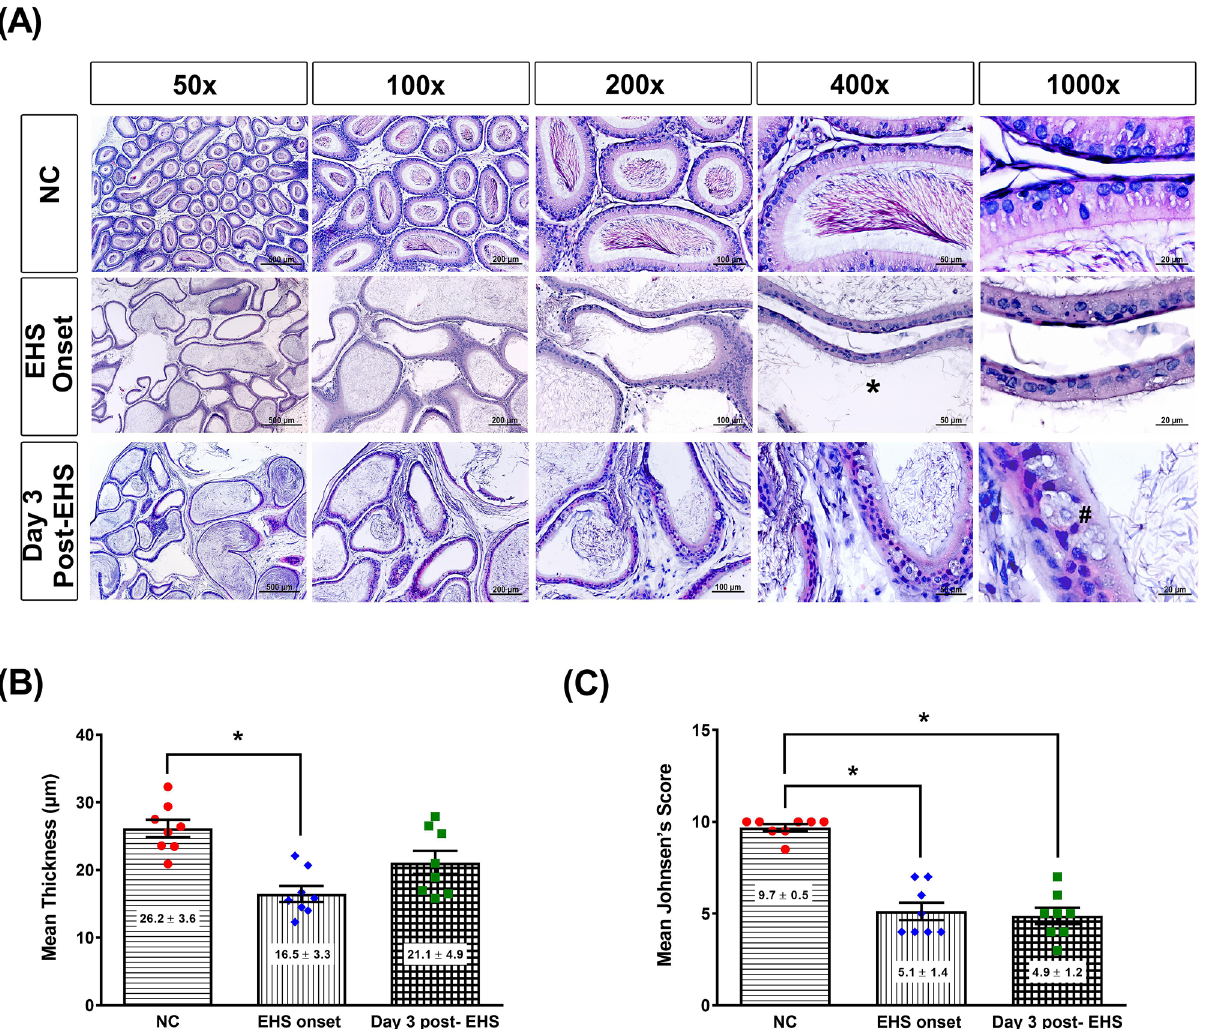
Figure 4. Histological alterations and quantitative analysis of rat epididymis tissues from the three groups. ( A ) Representative histological images are resented, following hematoxylin and eosin staining of the epididymis of rats from the NC, EHS onset, and Day 3 post-EHS. Images of epididymis morphology are shown at ×50, ×100, ×200, ×400 and ×1000 magnification. Scale bars = 500 μm, 200 μm, 100 μm, 50 μm, and 20 μm. ( B ) The mean thickness of the epididymis basement membrane and ( C ) the mean Johnsen’s score were presented as mean ± standard deviation (n = 8 per group). The EHS rats had a reduction of both mean thickness and mean Johnsen’s score of the cytoplasmic membrane, spermatids (#), and cytoplasmic degradation (*). *P < 0.05, EHS onset vs. NC or Day 3 post-EHS vs. hormones, multiple vital organs injury indicators, and disseminated intravascular coagulation (DIC). These EHS reactions lasted at least up to three days post-EHS. All EHS animals that were followed over the 14-day recovery period survived the EHS challenges (data not shown). Heat stress and heat illness arise when ambient tempera- tures are high. They can be triggered by physical exertion even at low-risk temperature 16 . Physical exertion can lead to heat stress and heat illness (due to intense and rapid heat production in the working muscles). Higher environmental temperatures further increase the risk. Thus, our present model fulfills that EHS is associated with excessive hyperthermia (over 40 °C Tco), encephalopathy, and confusion or coma during or just after strenuous physical activity in young, previously healthy subjects 17 . Indeed, in our rats, EHS occurs within the first 2 h of exertion and not necessarily at high ambient temperatures 18 . Compared to classic heat stroke, the death rate from EHS is relatively low or zero. Acute exposure (from seconds to a few hours) to stressors such as immobilization 19 , electric foot shocks 20 , cold, ether 21 , exercise 22 , food restriction 23 or anxiety situations 24 in males causes an increase in corticotropin- releasing hormone, adrenocorticotropin hormone (ACTH), β-endorphins and corticosterone. In rats, acute exposure to noise or water immersion 25 , immobilization 26 , cold 27 , hot 28 , light 25 or surgery 29 stimulates hypothal- amus-pituitary–gonadal (HPG) axis and causes an increase of follicle-stimulating hormone (FSH), luteinizing hormone (LH), and testosterone in the plasma of stressed males. Our present results showed that EHS caused by